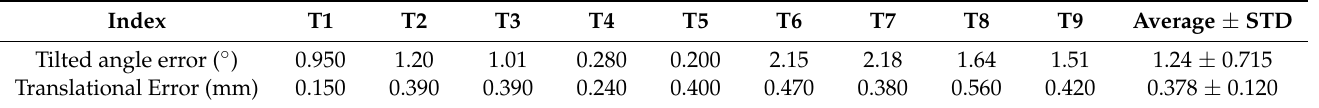
Table 2. Tilted angle error in the parallelization step and translational error in the fine-positioning